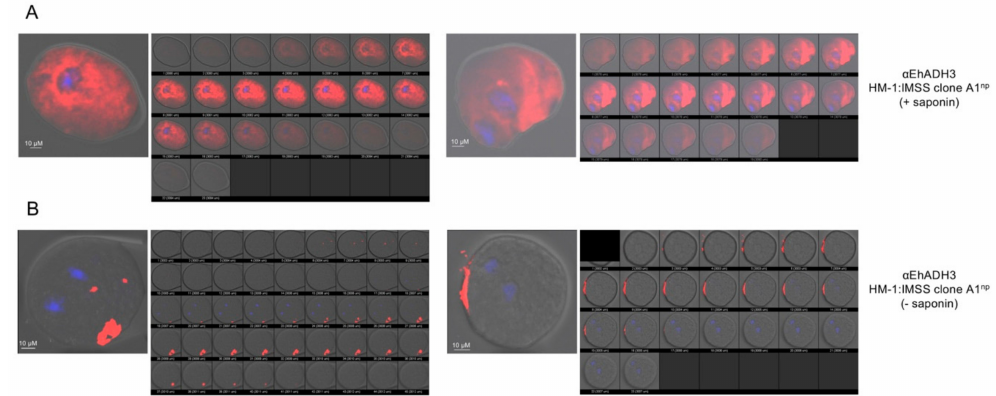
Figure 7. Localization of EhADH3B b in clone A1 np using polyclonal EhADH3B b antibodies confocal microscope (Olympus IX81 microscope with the FluoView Version 1.7b software; Olympus, Hamburg, Germany). Amoebae were fixed with paraformaldehyde and treated with: ( A ) ( + ) or ( B ) without ( − ) saponin. The trophozoites were incubated with anti-EhEADH3B (diluted 1:200 in NaPBS ± saponin), followed by Alexa Fluor ® 488 goat anti-mouse secondary antibody. Hoechst staining was used to visualize